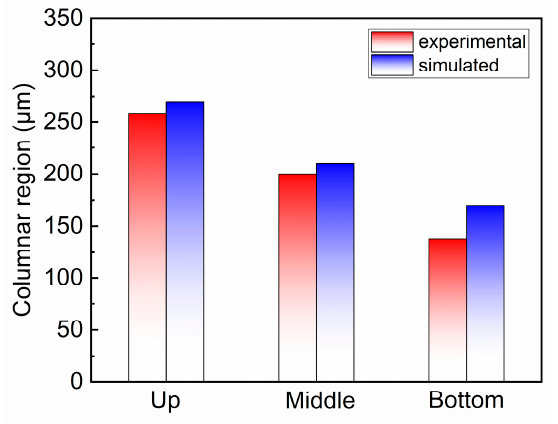
Figure 14. Quantitative comparison in the length of the columnar region between experimental and simulated results. The experimental results are obtained from Figure 3, and the simulated results are measured from Figure 11.